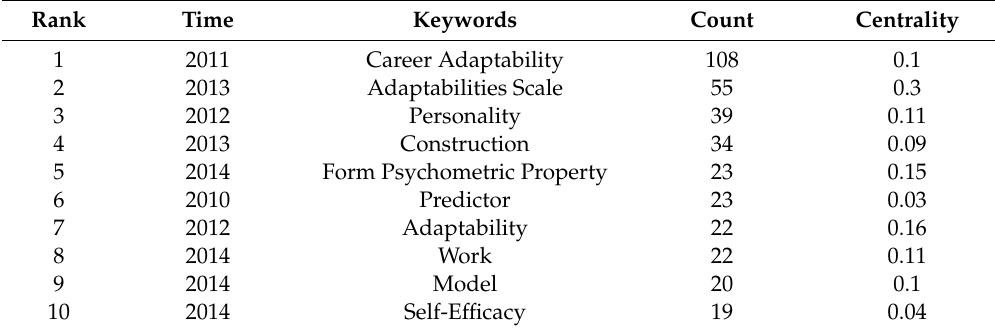
Table 3. Top 10 keywords in career adaptability